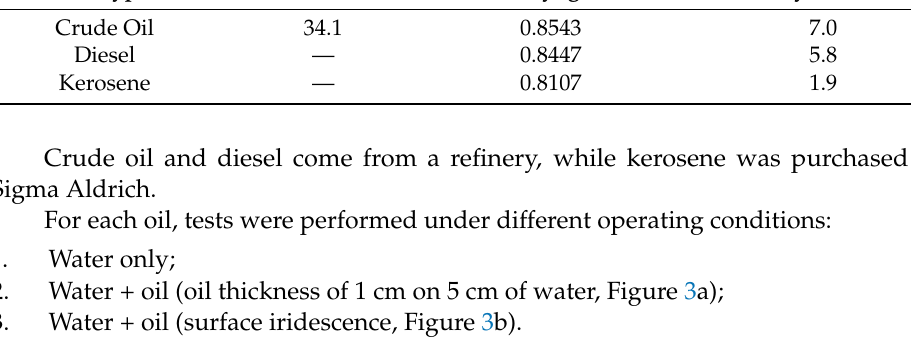
Table 1. Properties of the oils used for laboratory tests.